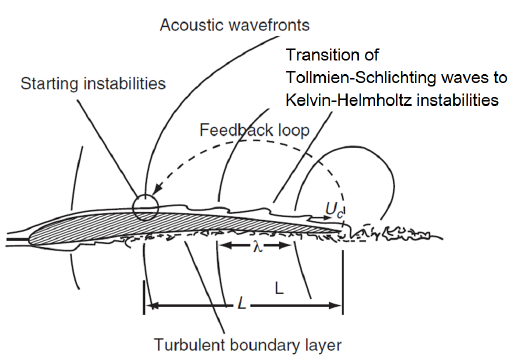
Figure 24. Suggested acoustic feedback loop revised from Longhouse